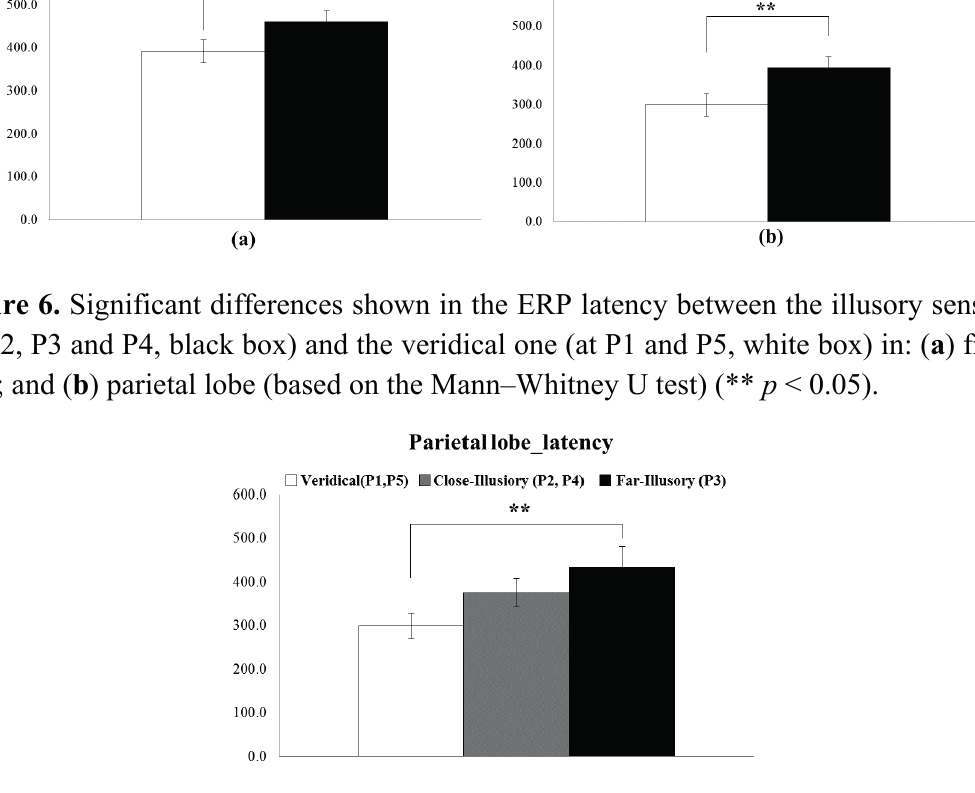
(P3, black box) and veridical (P1 and P5, white box) sensation in all of the parietal lobe (based on the Kruskal-Wallis test) (** p <